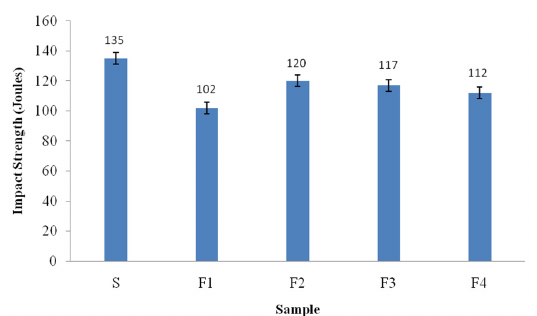
Figure 6. Impact Strength from Sample taken from Sound and Failed Crusher Jaws.